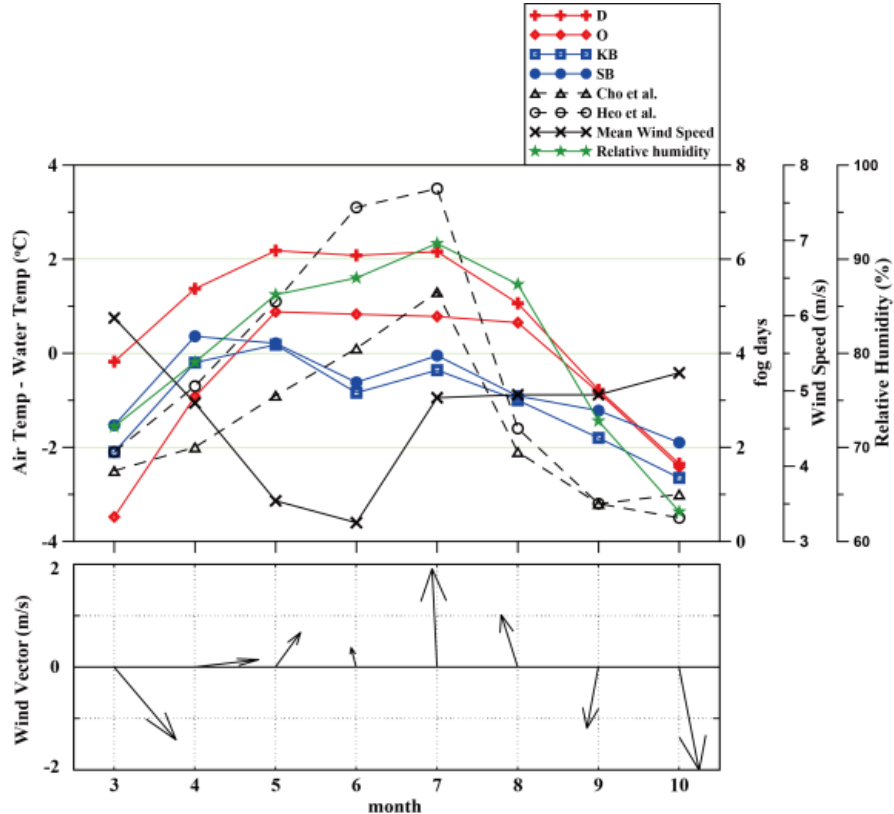
Figure 11. Monthly evolution of differences (°C) between the surface air temperature and the SST measured by the ocean buoys D (cross), O (diamond), KB (square), and SB (closed dot). Temperature differences were calculated from the hourly data. The monthly variation of sea foggy days from March to October from Cho et al. [14] and Heo et al. [39]. The monthly variation of relative humidity (green star) and wind speed (black cross) are in the upper panel. Variations of monthly mean wind vector are in the lower panel.